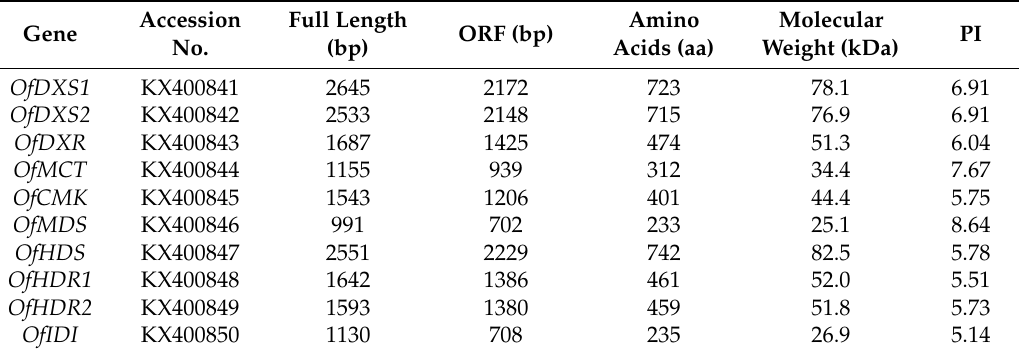
Table 1. Sequence characteristics of 10 MEP pathway genes in Osmanthus fragrans